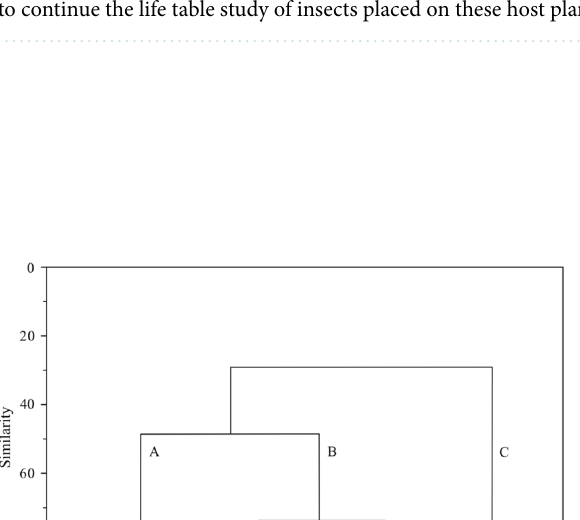
Table 3. Biological life table parameters (median ± SE) for T. absoluta when developing on different solanaceous species. R 0 (offspring/individual), T (days), r m (day −1 ), Dt and λ (day −1 ); Values followed by different letters were significantly different of according the Student’s t-test ( p < 0.05). The total of females tested for the study of T. absoluta biological life table parameters were 10 for S. americanum , 11 for S. melongena and S. gilo , and 15 for S. habrochaites , S. lycopersicum and S. tuberosum. Data for C. annuum , C. chinense and S. aculeatissinum were not included in the table because of the high mortality rate of larvae, making it impossible to continue the life table study of insects placed on these host plants.